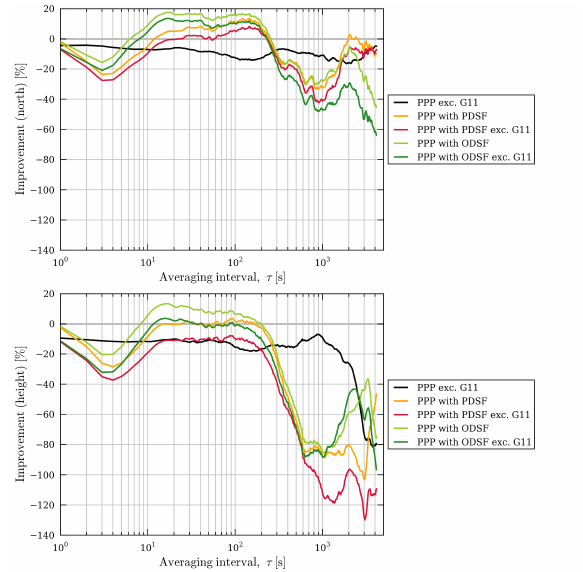
Figure 15: Figure showing the percentage improvement (i.e. reduc- tion) in Allan deviation in northing (top) and height (bottom) for station UCL, relative to the Allan deviation values corresponding to standard PPP processing that are shown in Fig.